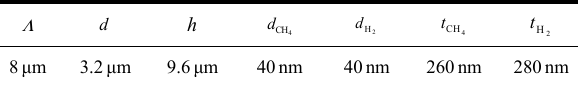
Table 2 Structural parameters of the sensor.